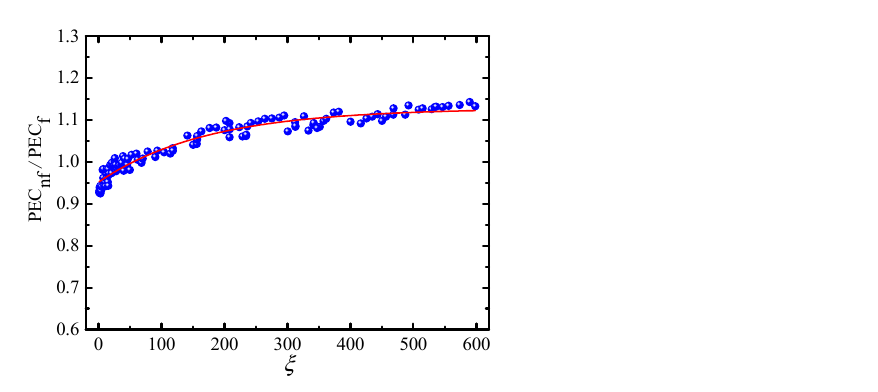
Figure 16. Relationship between PEC nf /PEC f and ξ . ● : numerical data; ⸺⸺ : Formula (25).